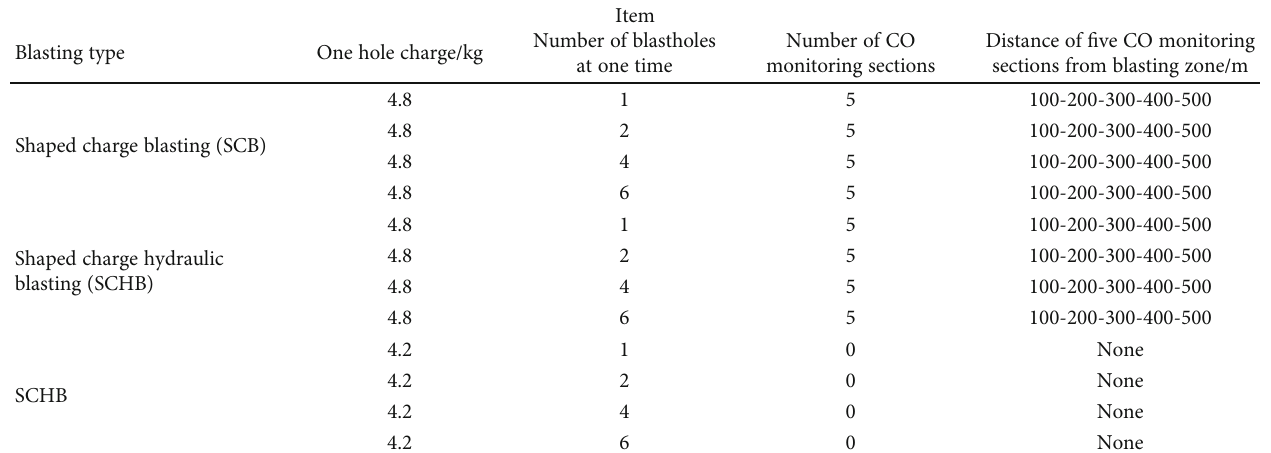
Table 2: Designed test scheme.